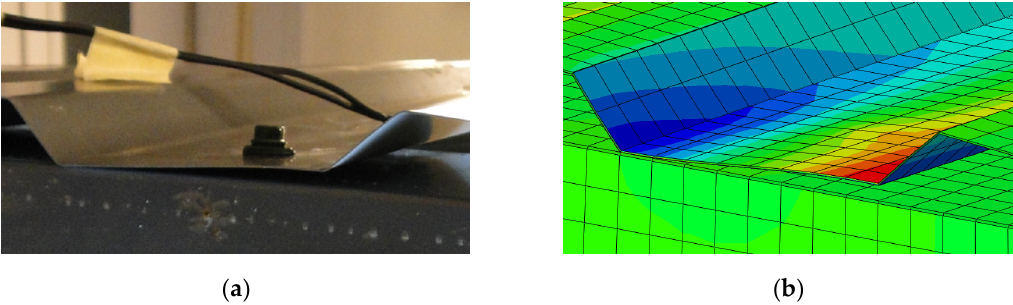
Figure 12. The comparison of the shape of the profile deformation: ( a ) test, ( b ) numerical model.